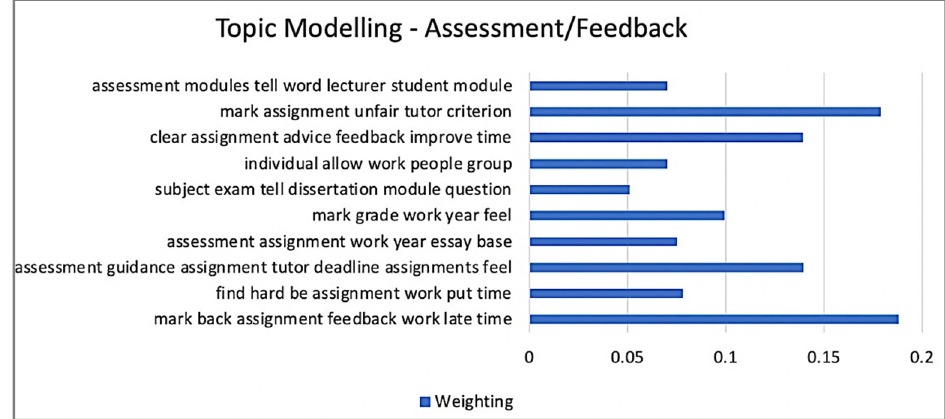
Figure 8. The 10 most important topics in the ‘Assessment and feedback’ category.